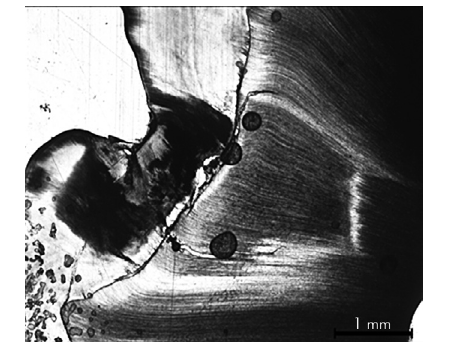
Figure 3. Light microscopic image of advanced dentin caries.